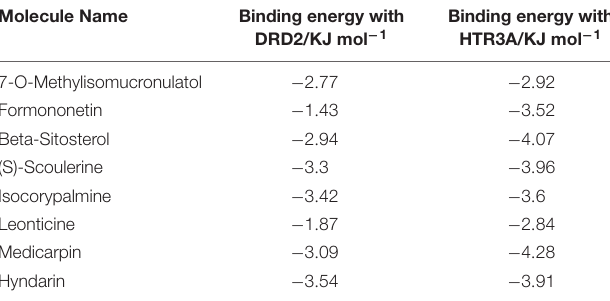
TABLE 5 | Results of ligand-receptor protein molecular